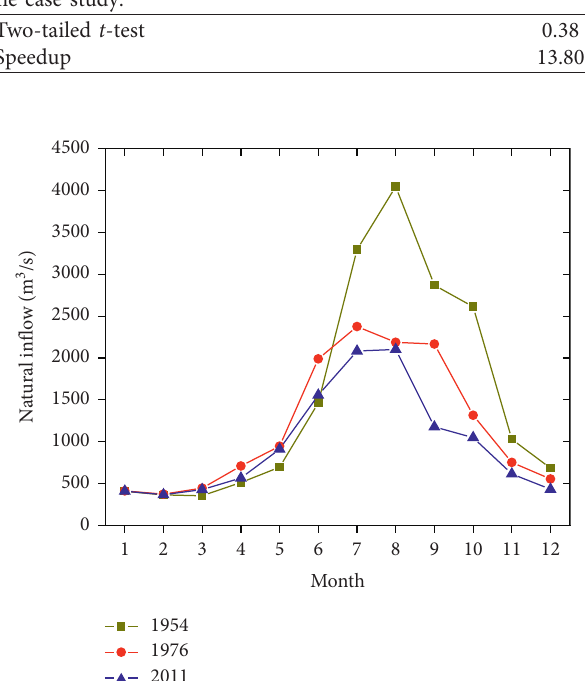
Figure 6: Natural inflow records of the three typical years.